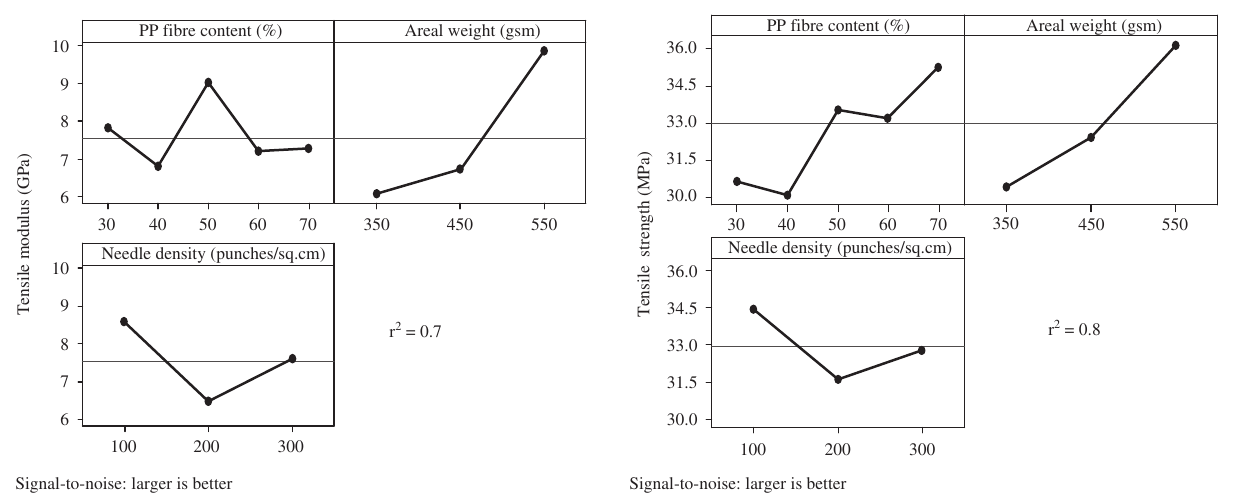
1 ′ Indicates dummy level adopted for the study. Actual values in indicate actual factors.